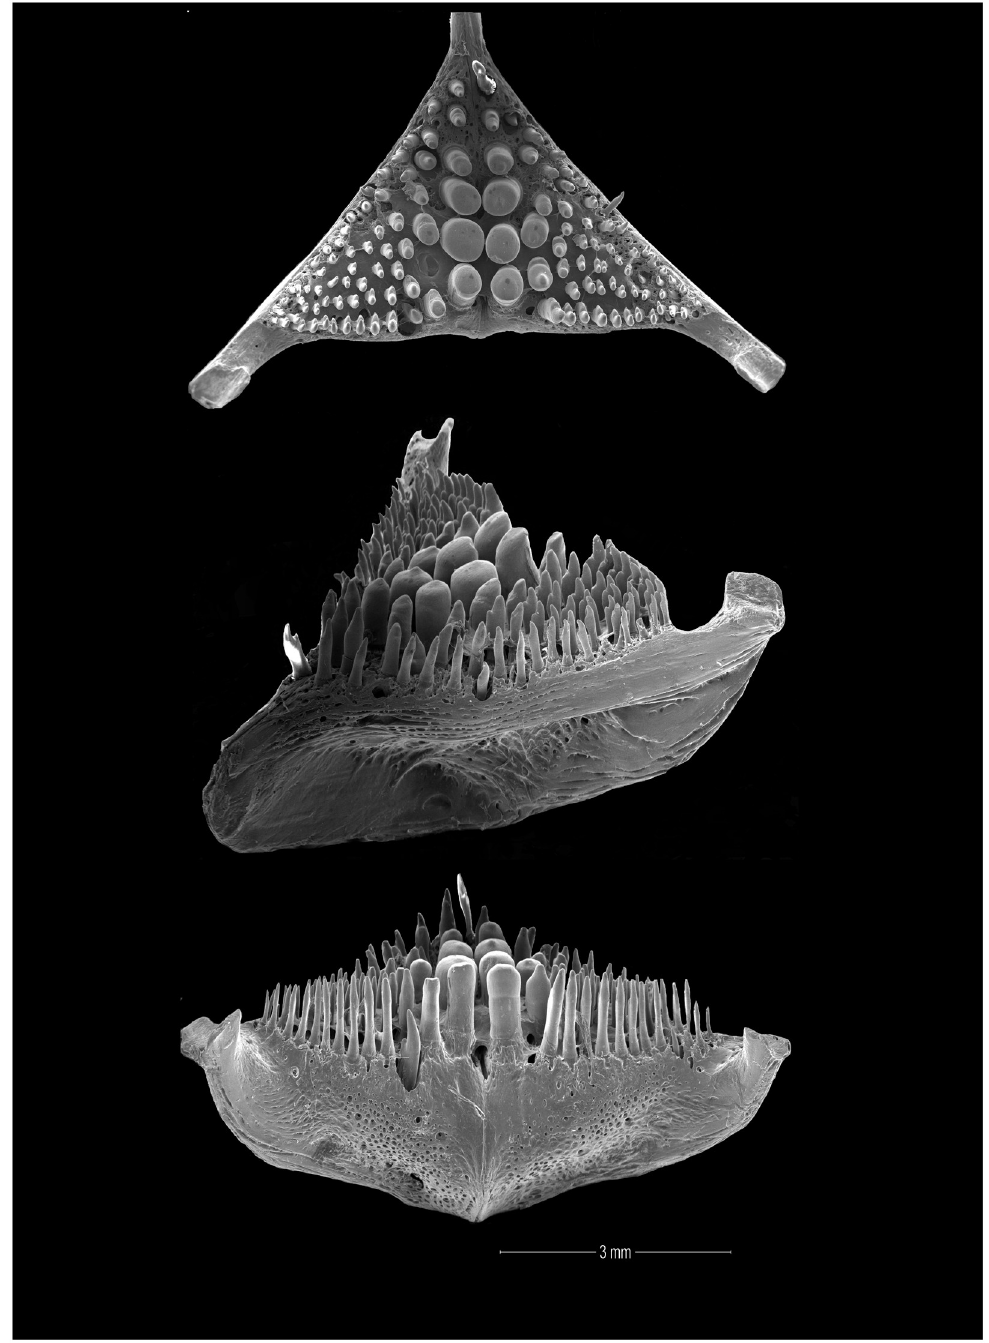
Fig 27. Australoheros mboapari ; lower pharyngeal tooth plate in occlusal (top), anterolateral (middle) and caudal (bottom) aspect; MCP 230444, 68.4 mm SL. indistinct. Bar 1 and Interbar 1 commonly absent, as caudal peduncle of same colour as cau- dal-fin base. Bars and Interbars straight vertical. Lateral band indistinct, expressed as contigu- ous black spots on anterior scales in E1 row and variably on anterior scales in row 0; continuous to Bar 5, variably expressed, but not distinct posteriorly on side.